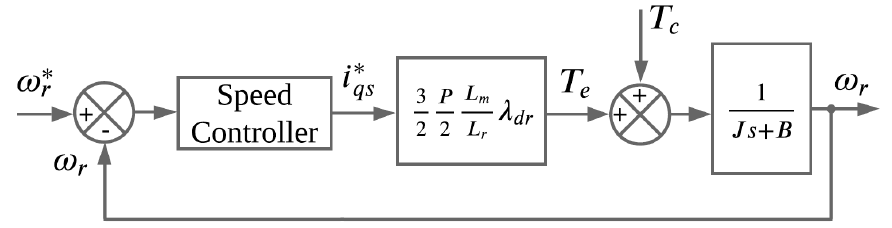
Figure 17. Speed control loop diagram.